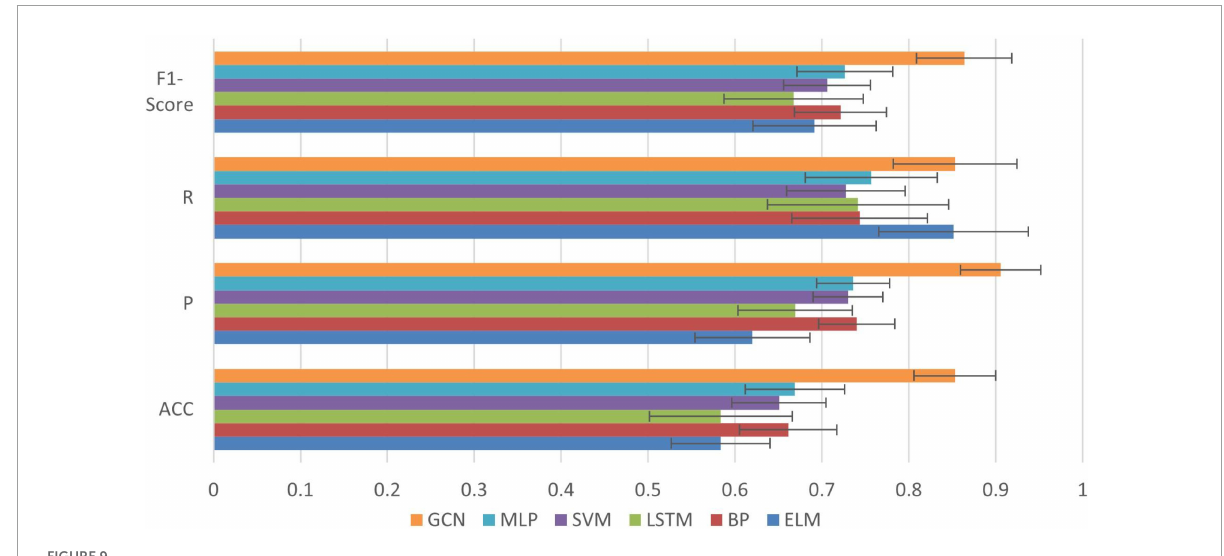
FIGURE9 Comparison of classification results between GCN and other common algorithms.